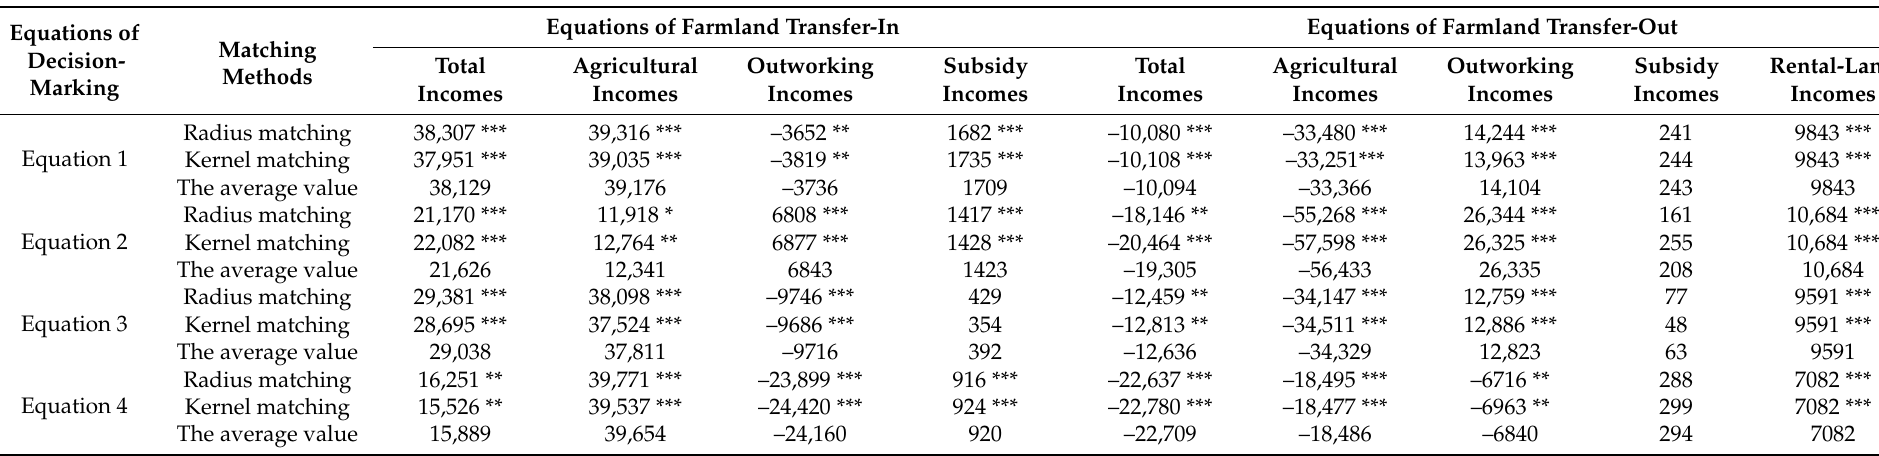
Table 5. The comparison of average treatment effects on the treated ( ATTs) for Propensity Score Matching (PSM) of rural households with transferring farmland.